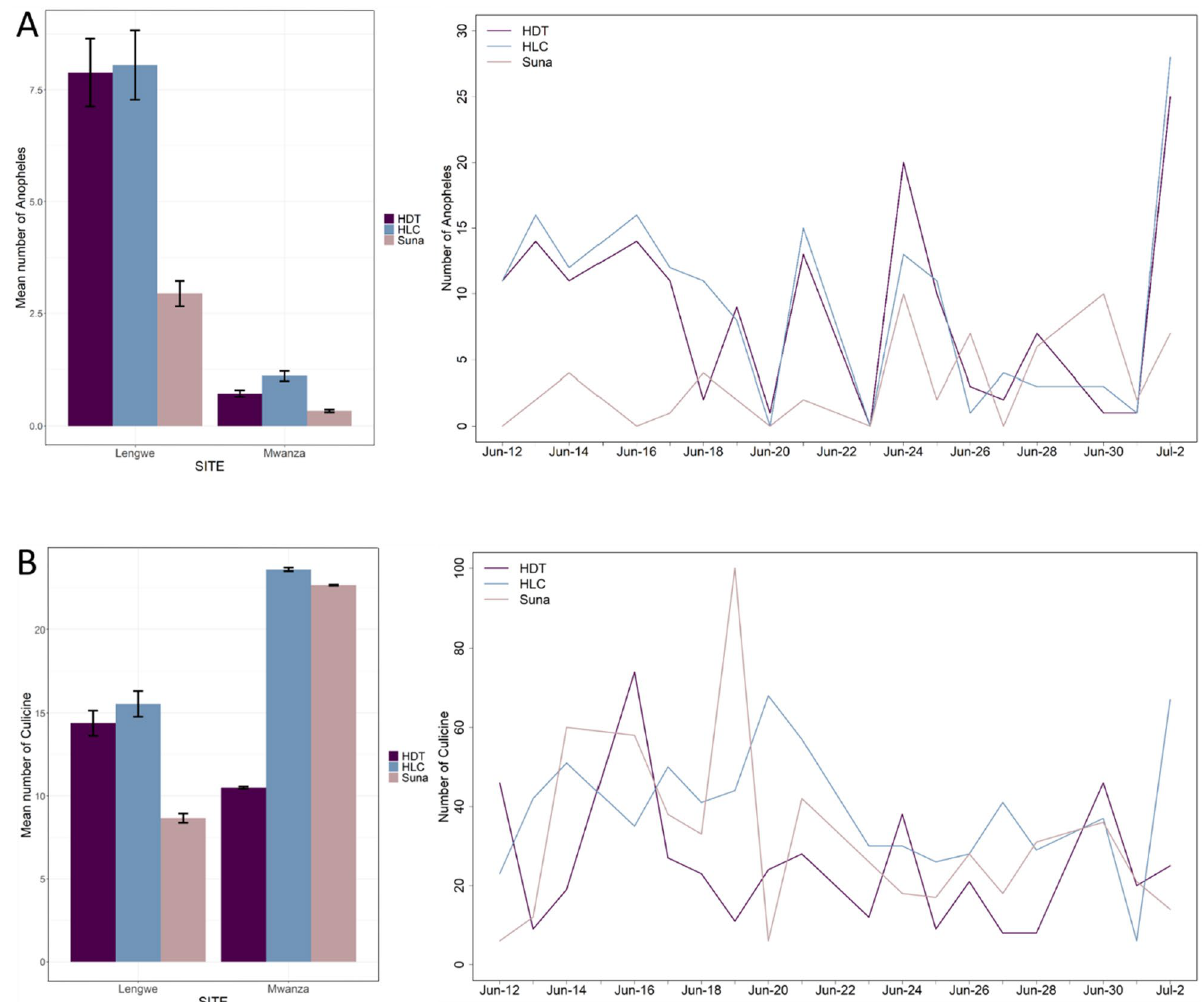
Figure 1. The mean number of mosquitoes caught per trap per night for each trapping method in Mwanza and Lengwe (± s.e.m) and a breakdown of the total number of mosquitoes caught per night in both villages. Data are presented for Anopheles (panel A ) and culicines (panel B ).